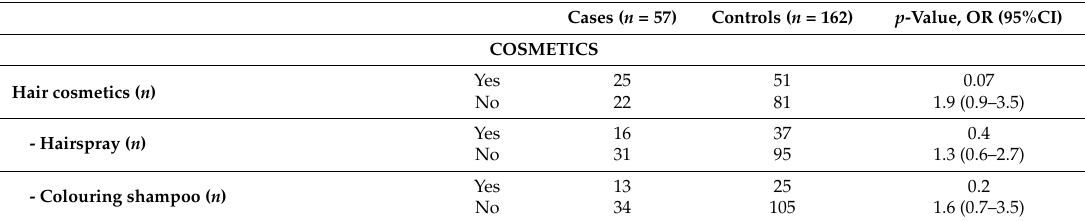
Table 4. Univariate analysis of the association between pollutant exposures during the first trimester of pregnancy and the incidence of